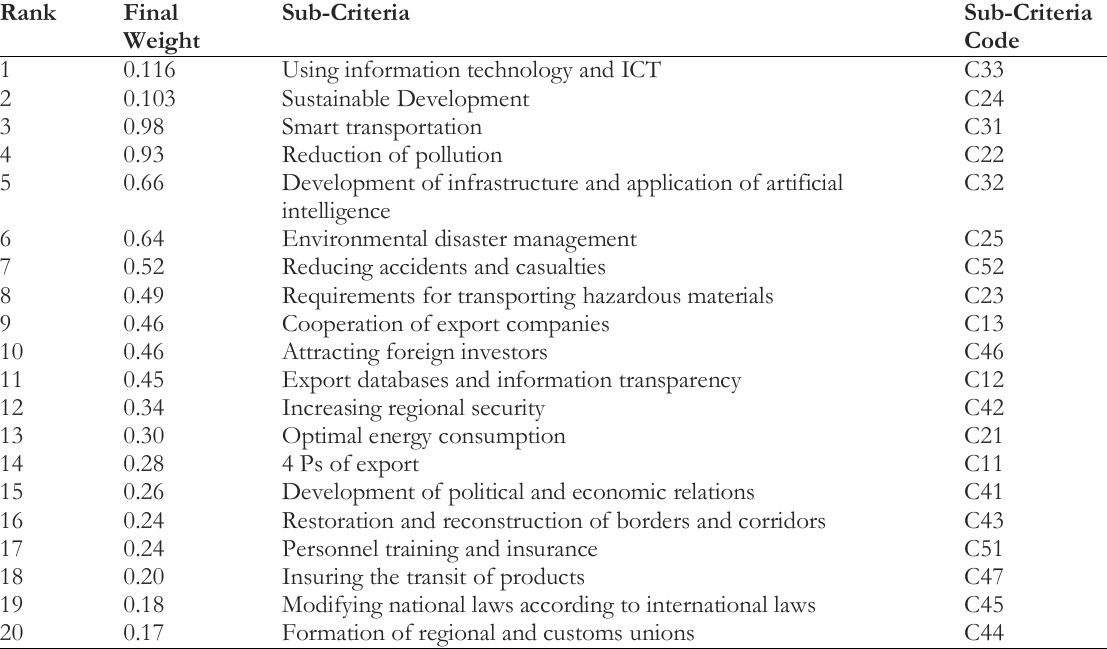
Table 14. Prioritization of marketing strategies for the transportation development in the